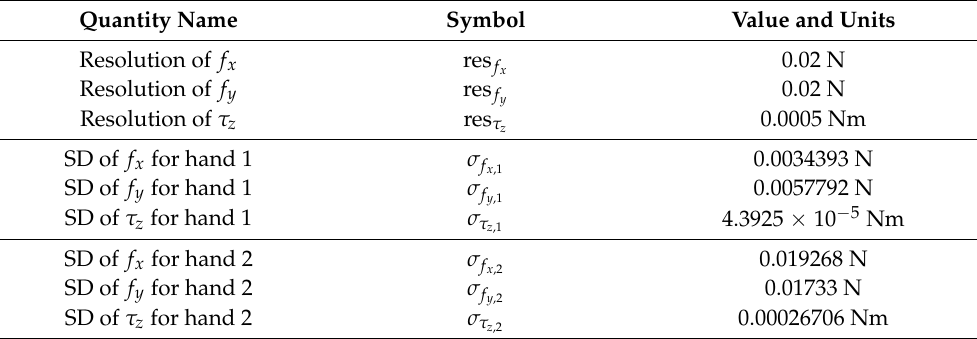
Table A1. Comparison of experimentally obtained standard deviation (SD) with sensor resolution reported in the